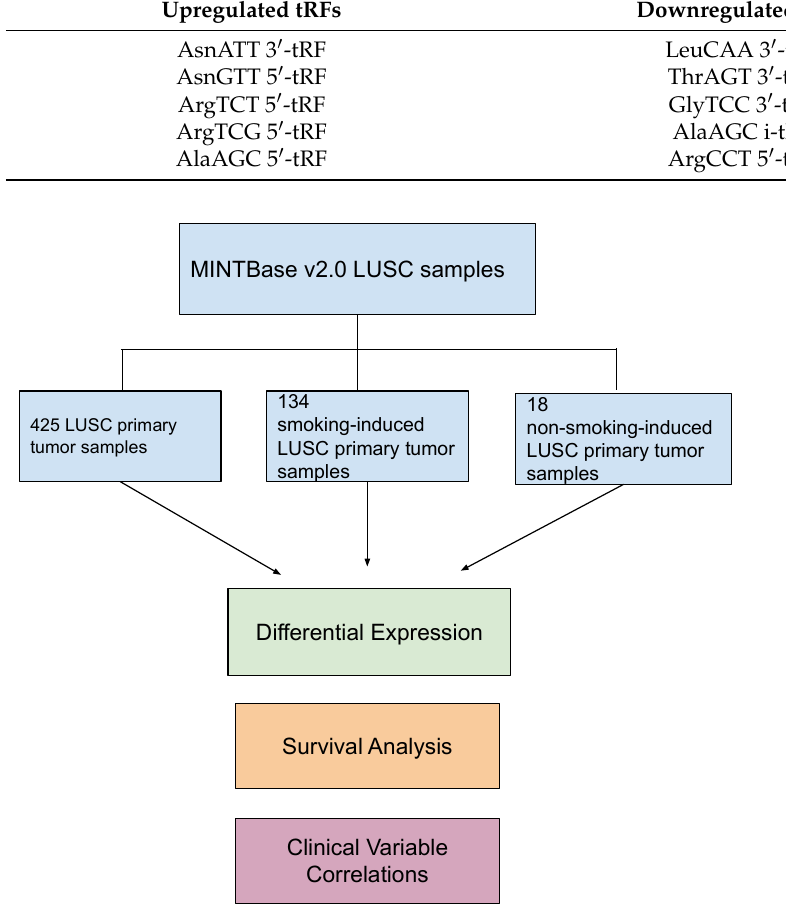
Figure 1. Schematic of project workflow. Transfer RNA-derived fragment (tRF) counts were extracted from MINTbase v2.0 (https://cm.jefferson.edu/tcga-mintmap-profiles/; accessed on 14